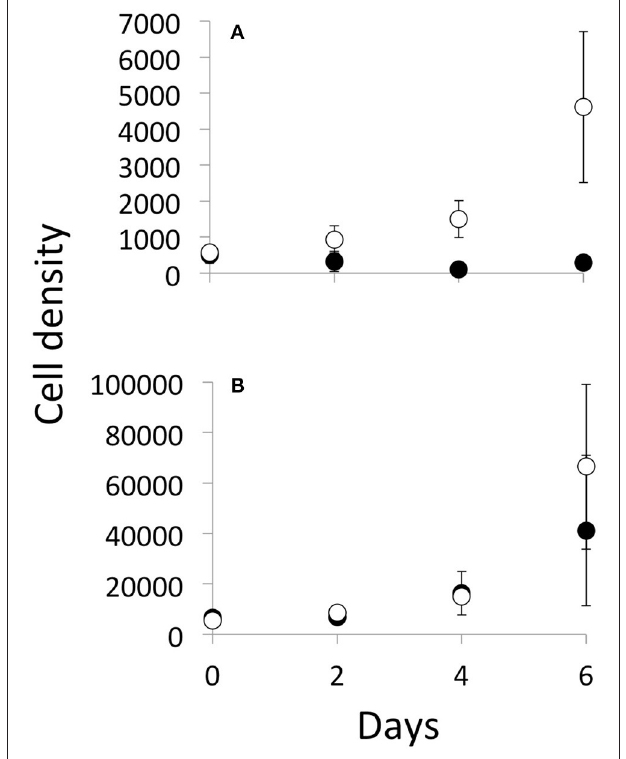
FIGURE 1 | Temporal trend of mean cell density for Cryptomonas (A) and Microcystis (B) in the allelopathy experiment showing the mean cell density (cell.mL − 1 ) measured in single culture controls (empty circles, n = 3) and co-cultured treatments (solid circles, n = 9). Error bars represent confidence interval at 95%.